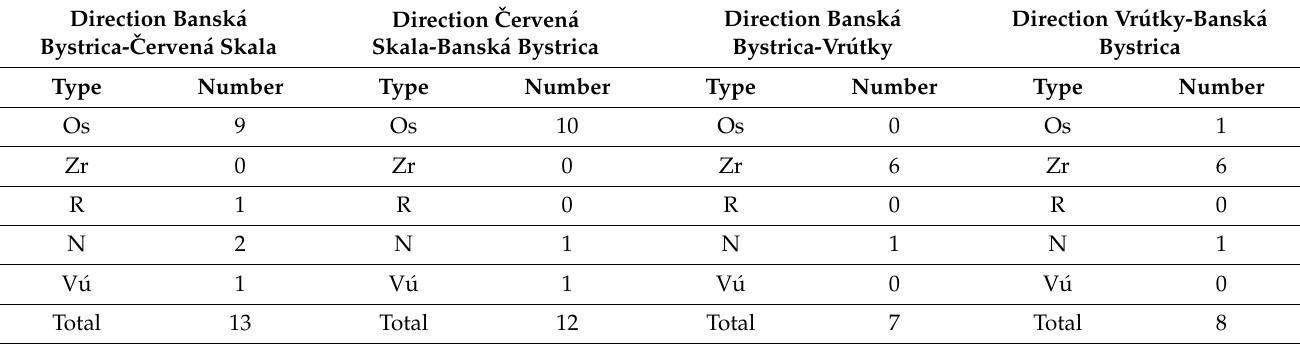
Table 2. Number and type of trains during the measurement BB1.